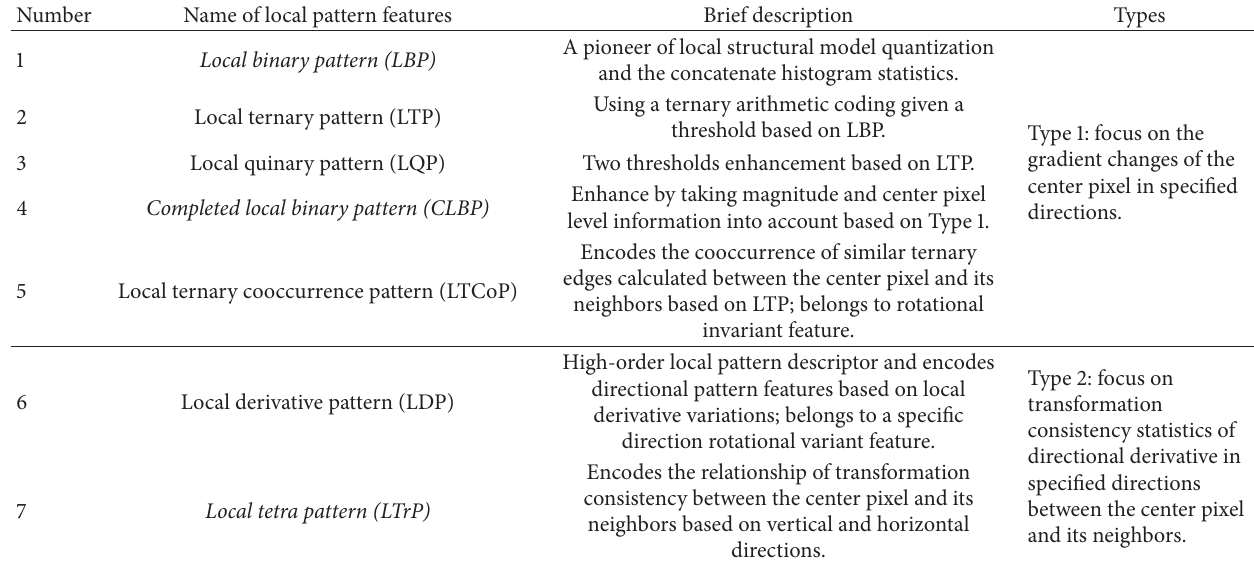
Table 5: Summarization of local pattern features focusing on bioimage informatics